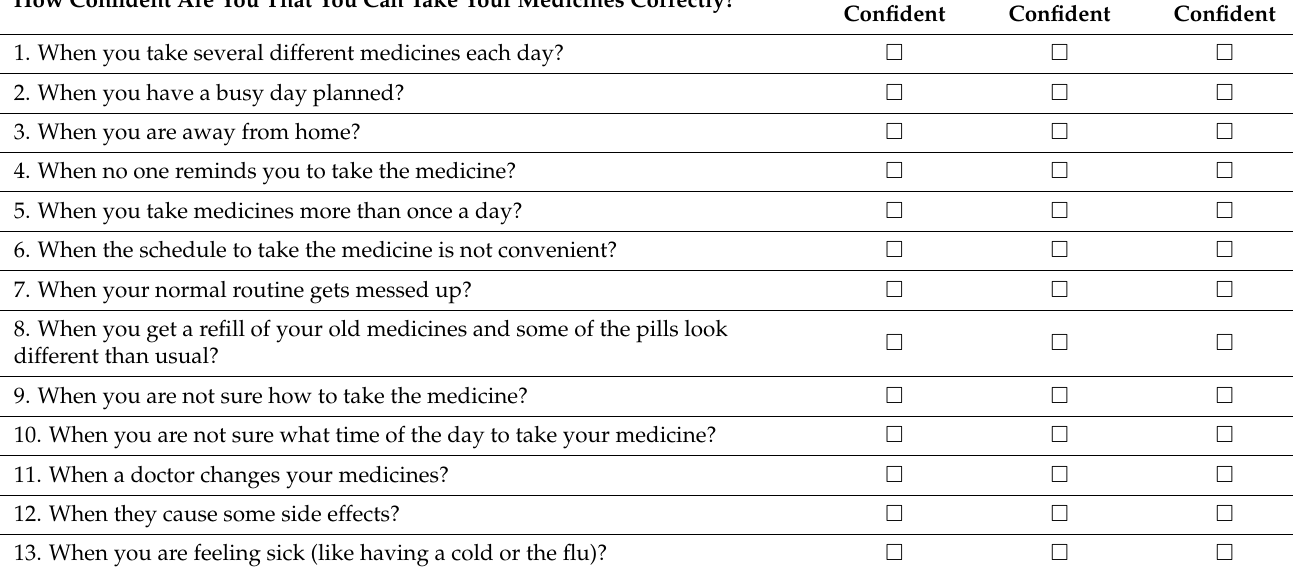
Table A1. Self-Efficacy for Appropriate Medication Use Scale